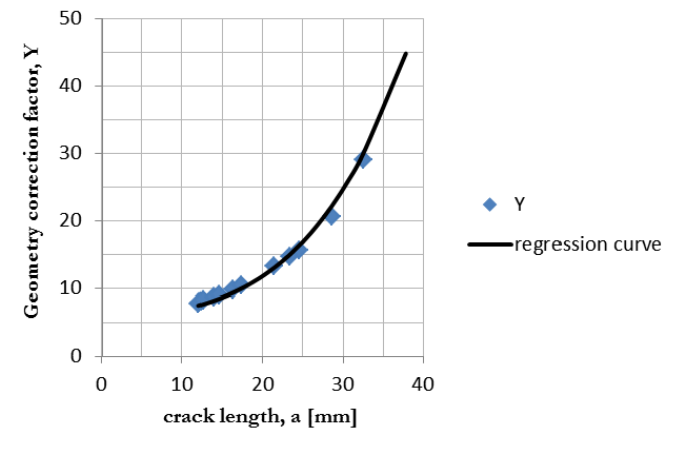
Figure 10: Geometry correction factor data for compact tension specimen (90° fibre